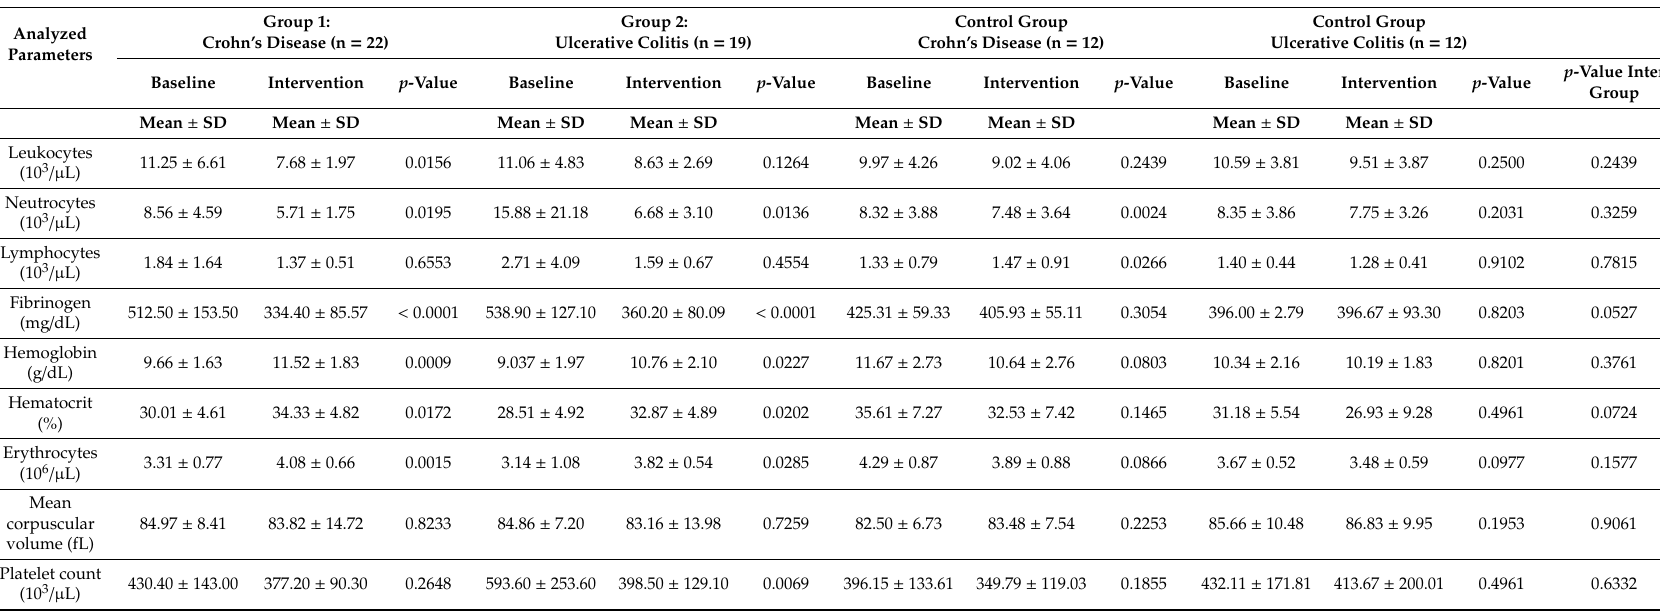
Table 2. Complete blood count changes over combined parenteral and enteral nutrition in inflammatory bowel disease (IBD) patients (n = 65). Analyzed